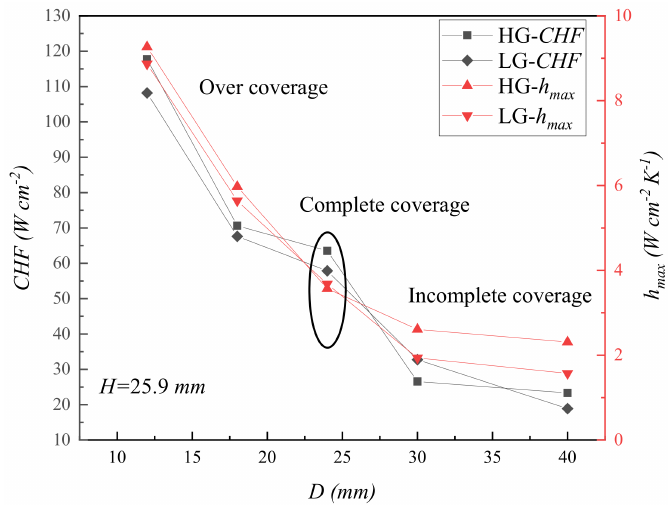
Figure 16. CHF and h max versus D at H = 25.9